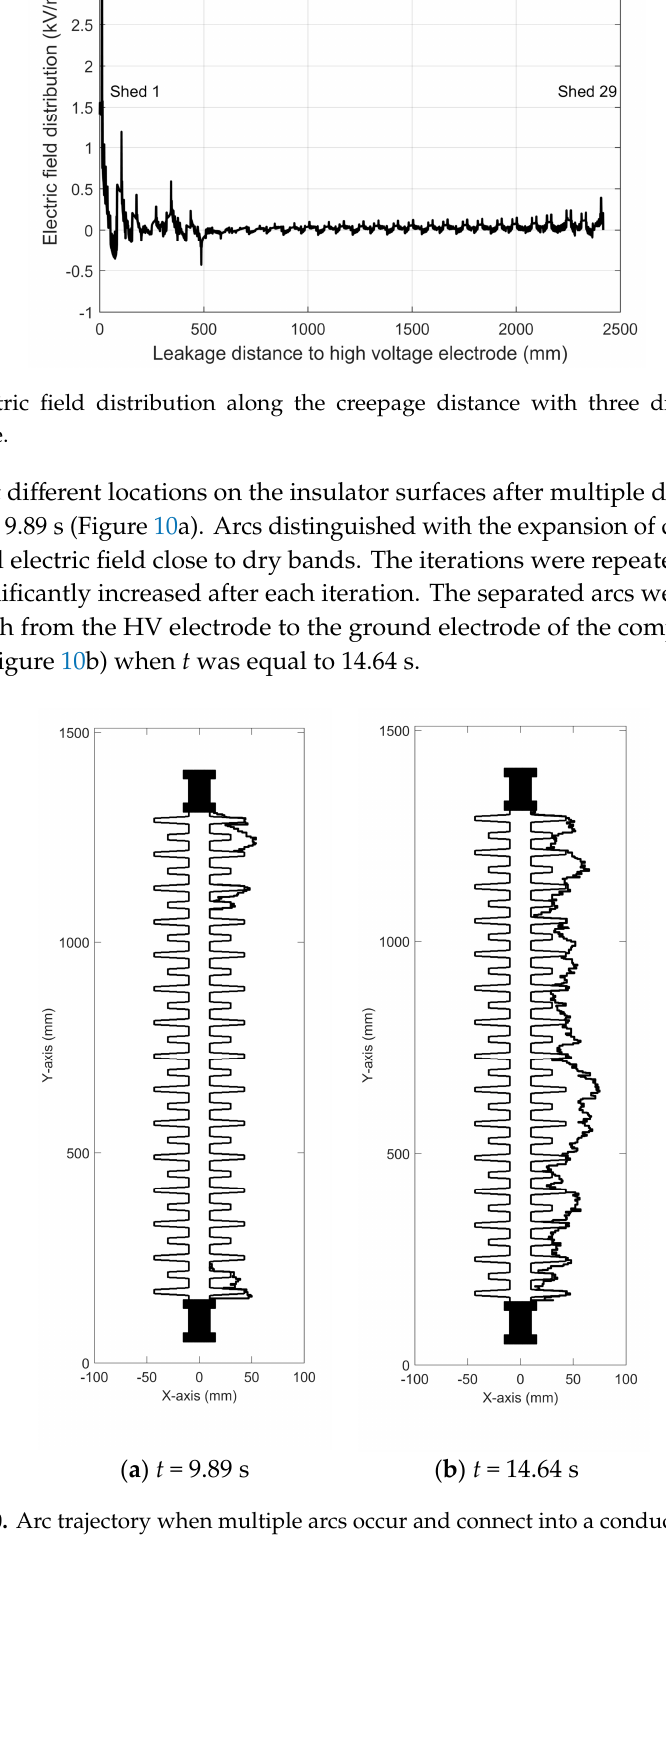
Figure 8. Dry bands and thermal field distributions close to the HV electrode.